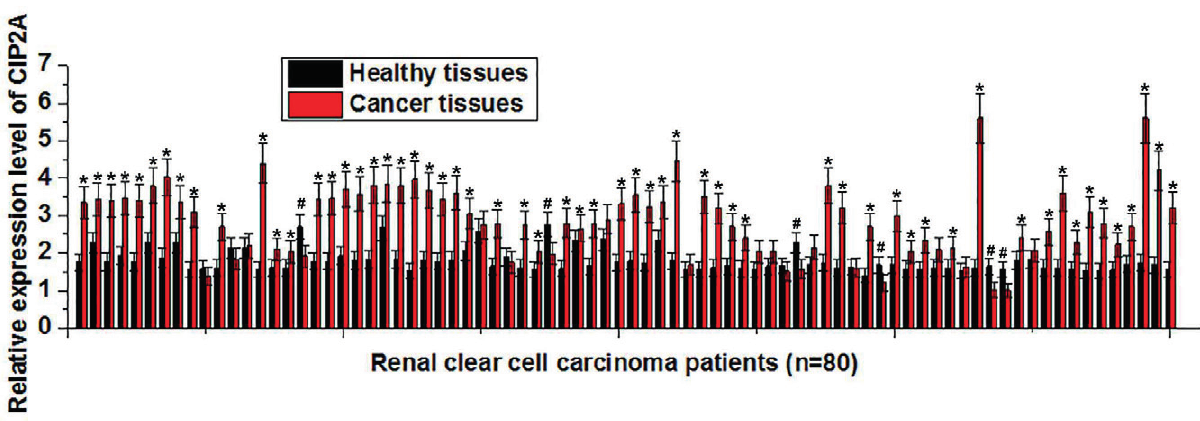
Fig. 1. Expression of CIP2A in tumor tissues and adjacent healthy tissues of 80 patients with renal clear cell carcinoma. Compared with health tissue in the same individual, P< 0.05; #, compared with tumor tissue in the same individual, P